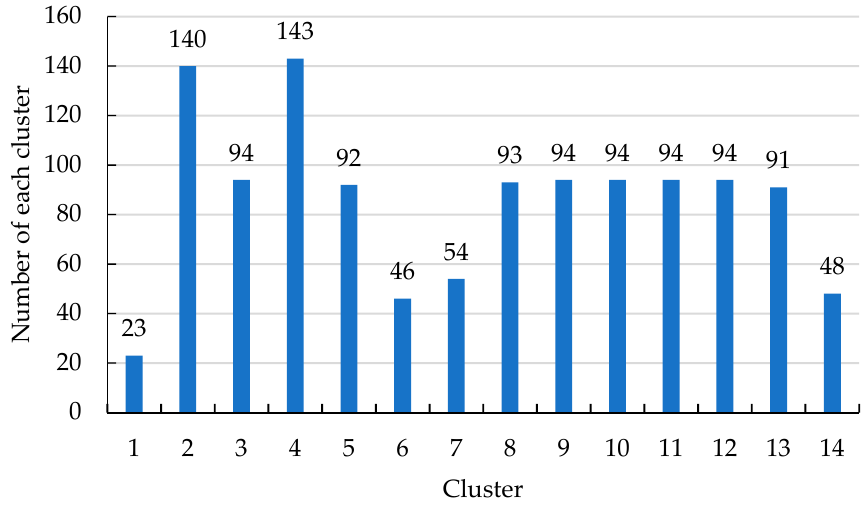
Figure 11. The number of the sheath current samples in each cluster.